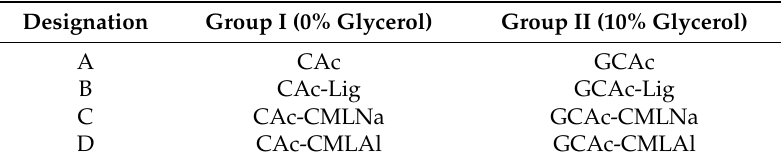
Table 5. Formulations used for the preparation of the